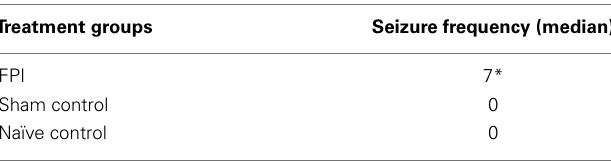
Table 2 | Chi-square results from contingency table analysis of median seizure